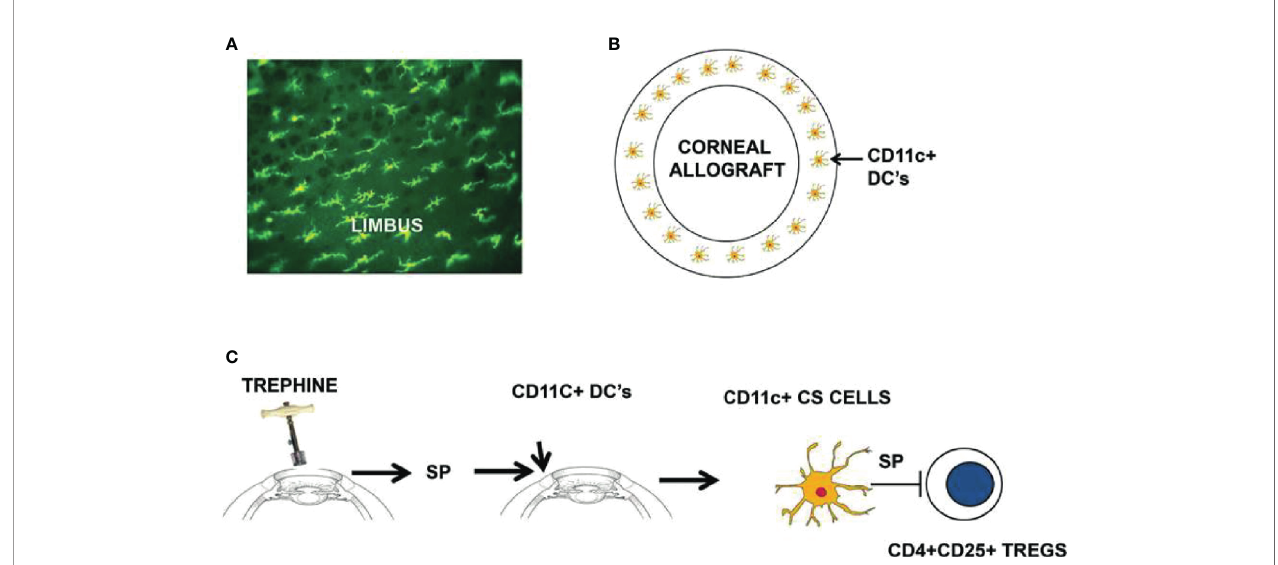
FIGURE 4 | Sympathetic loss of immune privilege is the result of an axis involving ocular surface CD11c + DCs, corneal nerves, and the elaboration of substance P (SP). (A, B) MHC class II + DCs (including CD11c + DCs) reside at the interface between the corneal allograft and the graft bed. (C) Severing corneal nerves with a trephine elicits the release of SP that converts resident CD11c + DCs to contrasuppressor (CS) cells that disable CD4 + CD25 + Tregs. Reproduced from Niederkorn (39) with permission from Invest Ophthalmol Vis